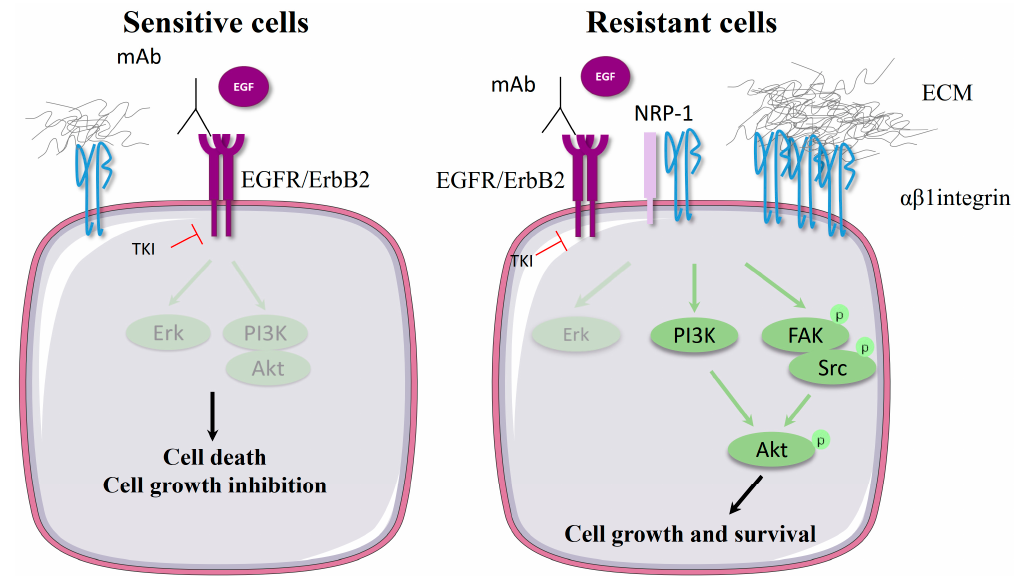
Figure 1. β 1 integrin induces EGFR- or HER (ErbB2)-targeted therapy resistance. In sensitive cells, the inhibition of the ErbB receptor family by either antibodies or tyrosine kinase inhibitors (TKIs) blocks Erk and Akt pathway activation leading to cell death and cell growth inhibition. In resistant cells, β 1 integrin or its associated extracellular matrix (ECM) proteins are often overexpressed, leading to the activation of β 1-downstream pathways such as PI3K or FAK / Src. These pathways converge to activate the serine kinase Akt that promotes cell survival and cell growth. Alternatively, β 1 integrin can be activated by coreceptors such as neuropilin-1 (NRP-1) to trigger EGFR-targeted therapy resistance independently of integrin-mediated cell adhesion.